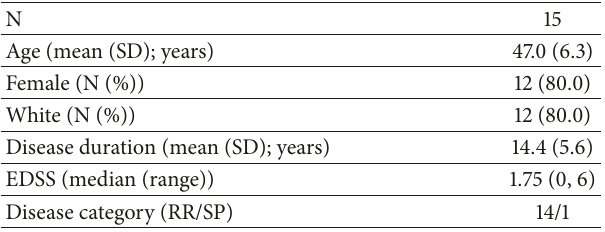
Table 1: Demographic characteristics of study